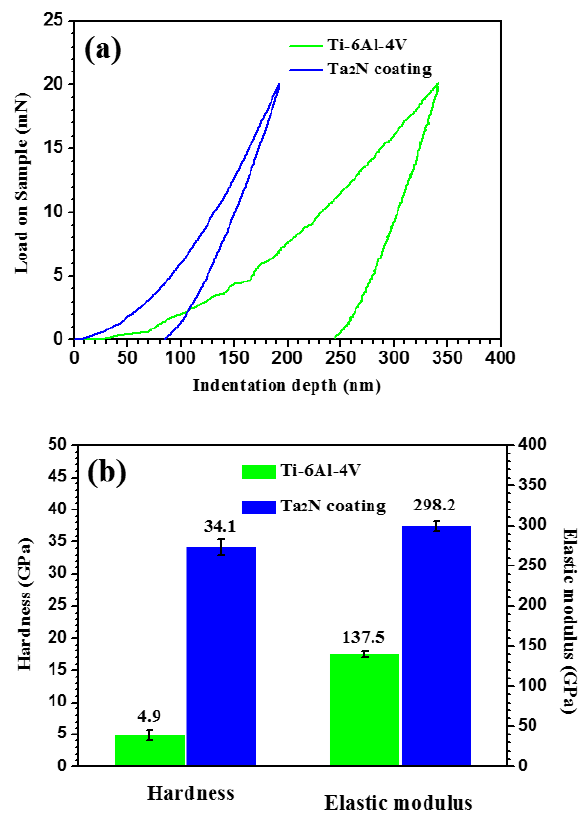
Figure 4. ( a ) Load-displacement curves and ( b ) hardness and elastic modulus for the Ta 2 N coating and uncoated